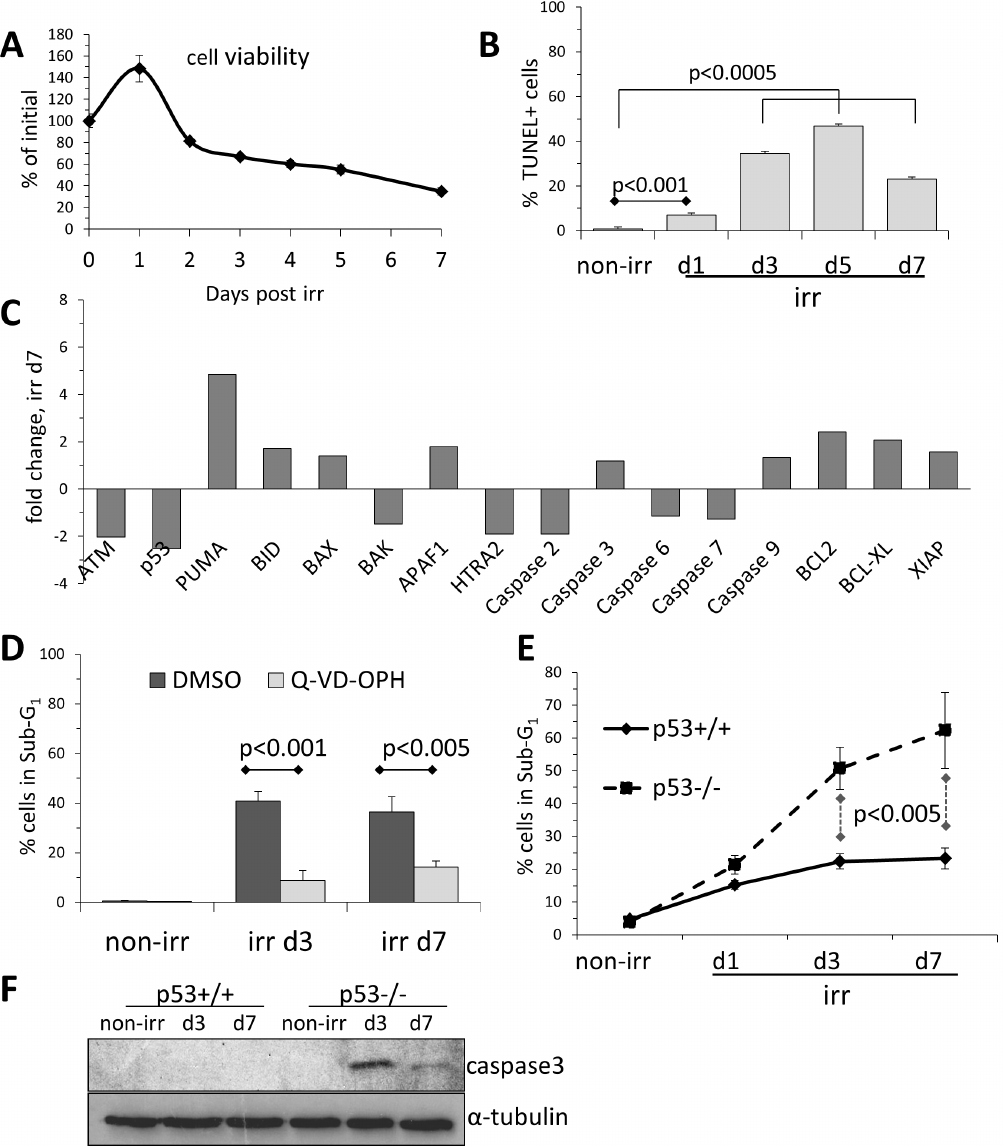
Figure 1. NSC undergo a delayed and p53-independent apoptosis upon irradiation. (A)NSC cell density before (T0, normalized b as 100%) and after irradiation as measured by colorimetric MTT assay. Error bars: SD. (B)Apoptosis analysis by flow cytometrical TUNEL assay on non-irradiated (non-irr) NSCs and following irradiation. Error bars: SD. (C)Expression changes in apoptosis-relevant genes in NSCs at day 7 after irradiation compared to non-irradiated NSCs, based on microarray dataset originally published in [6]. (D)Flow cytometry analysis for apoptosis-associated DNA fragmentation (Sub-G1) of irradiated NSCs treated with pan-caspase inhibitor Q-VD-OPH (10 m M). Error bars: SD. (E)Flow cytometry analysis for apoptosis-associated DNA fragmentation (Sub-G1) of irradiated p53-deficient and isogenic wild type NSC. Error bars: SD. (F)Western blot analysis of irradiated p53-deficient and isogenic wild type NSC for apoptosis-associated appearance of active caspase 3. Loading control: a -tubulin.